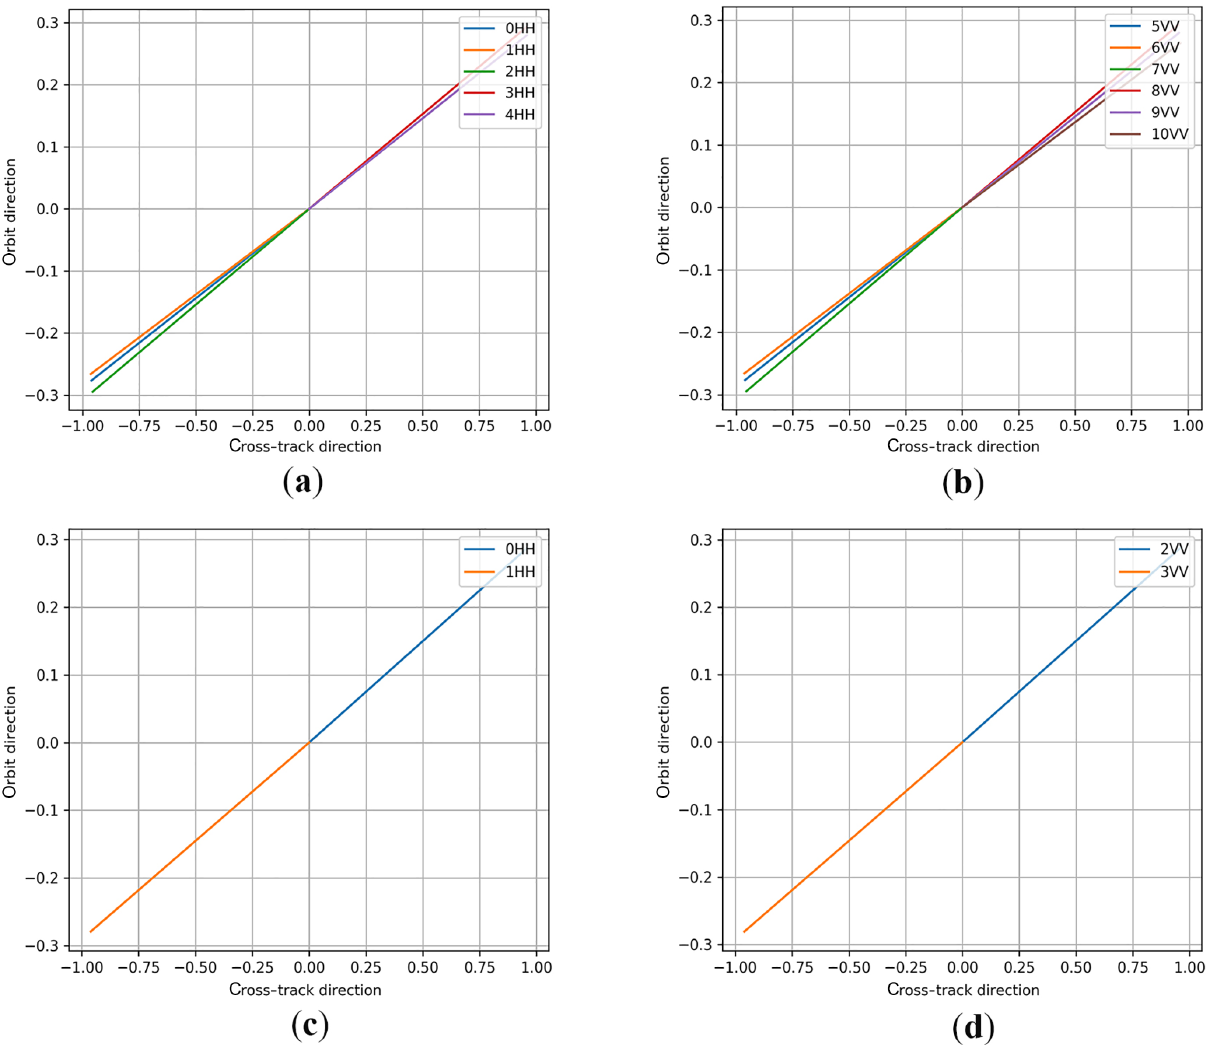
Figure 23. SCAT azimuth angle distribution of the WVC located at the nadir swath. (The values of x axis and y axis are for the angle display; they do not have actual meanings. The x axis is the cross-track direction, and the y axis is the satellite moving direction.) (a) Azimuth angles of the views with HH polarization. (b) Azimuth angles of the views with VV polarization. (c) Azimuth angles of the views with HH polarization (views with similar azimuth angles are aggregated into one view). (d) Azimuth angles of the views with VV polarization (views with similar azimuth angles are aggregated into one